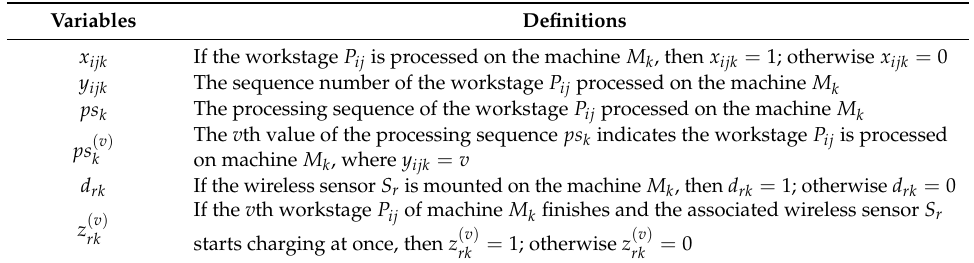
Table 2. List of Decision Variables for